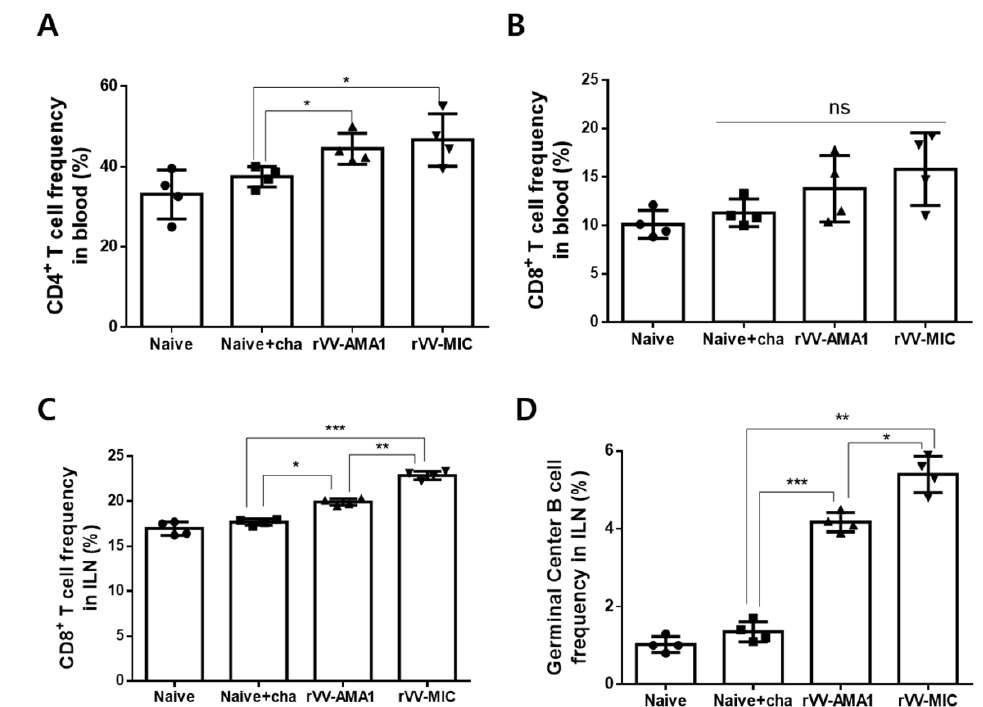
Figure 4. T cell and germinal center B cell response in blood and inguinal lymph nodes (ILN). Immunized mice ( n = 8) were challenge-infected with P. berghei, and blood samples were collected at 6 dpi. Inguinal lymph nodes (ILN) from mice were collected at 6 dpi. After surface marker staining with the fluorophore-conjugated antibodies, CD4 + ( A ) and CD8 + ( B ) T cell responses in the blood and CD8 + ( C ) T cell, germinal center B cell ( D ) responses in ILN were assessed by flow cytometry. Data are expressed as mean ± SD (* p < 0.05, ** p < 0.01, *** p < 0.001; ns: no statistical significance).